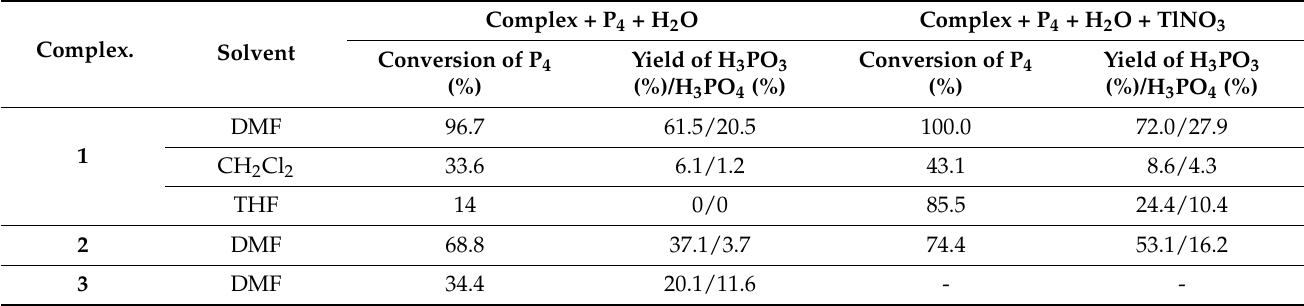
Table 1. Interaction of {Mo 3 PdS 4 } complexes 1 – 3 with P 4